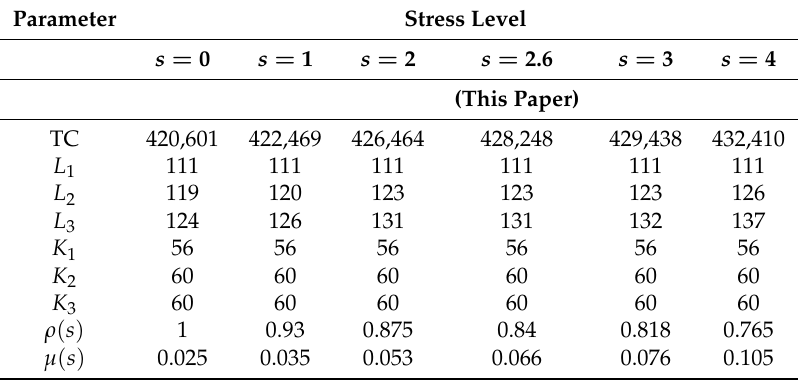
Table 5. Sensitivity analysis of the model with respect to the stress level of